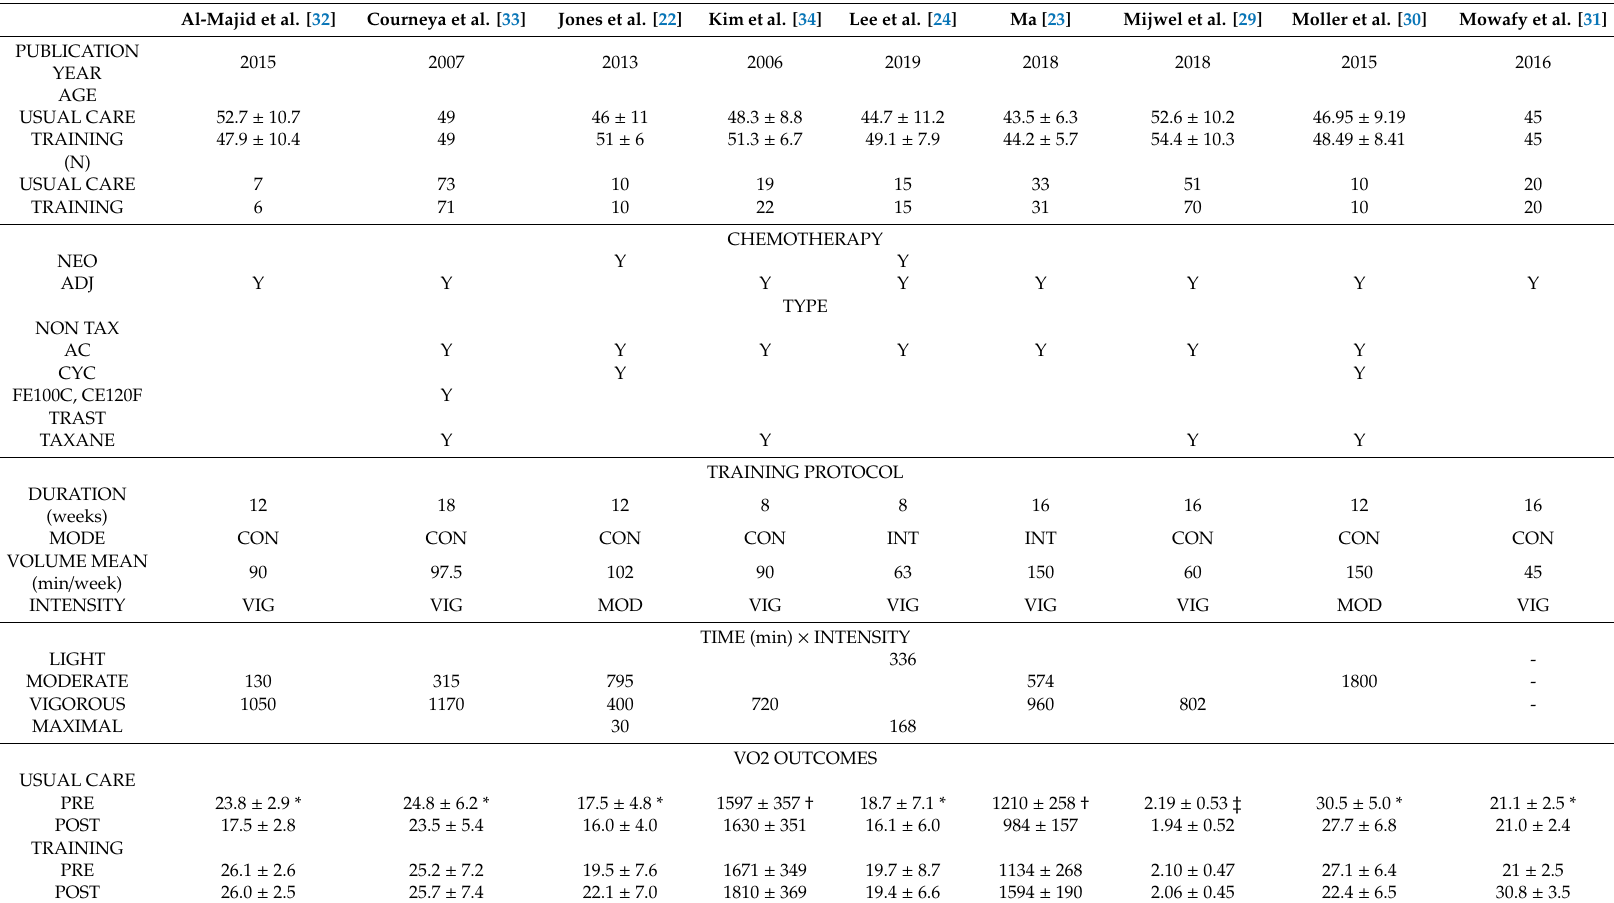
Table 1. Descriptive data of the studies included in the